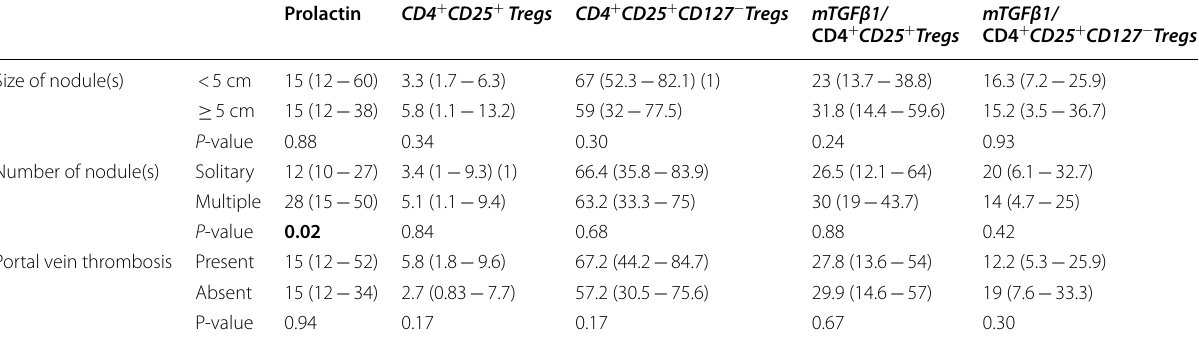
The data are expresses as median and 25–75% interquartile and compared by the Mann–Whitney